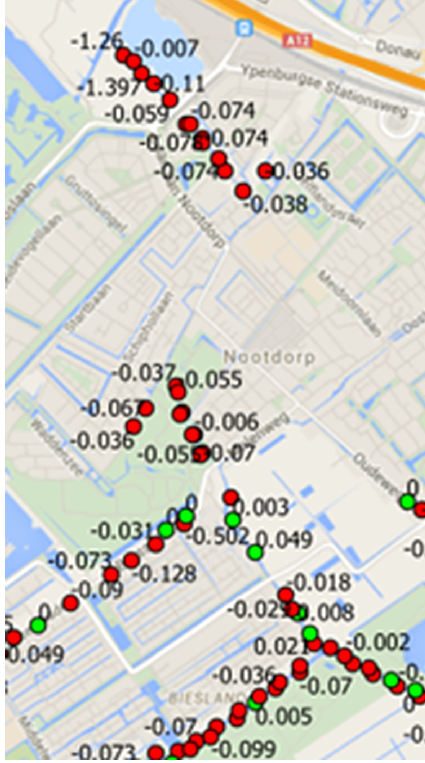
Figure 4. Calculated change in stability factor. Green dots mean an increase of the safety factor while the red ones indicate a decrease. The indicated values are the calculated decrases and